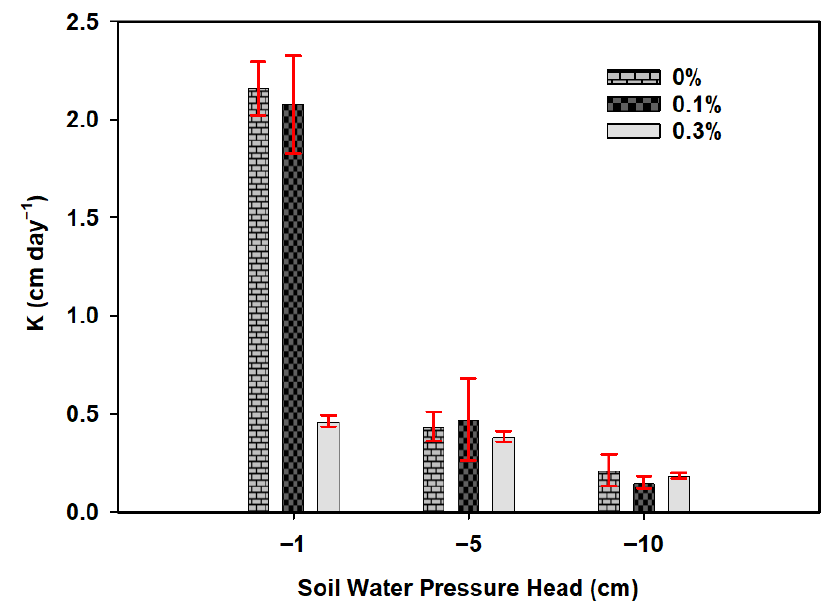
Figure 6. Near-saturated hydraulic conductivity ( K ) of the lignin-based hydrogel-soil mixtures at 0%, 0.1%, and 0.3% ( w / w ) treatment application rates. Error bars indicate standard error of the means (n = 3).